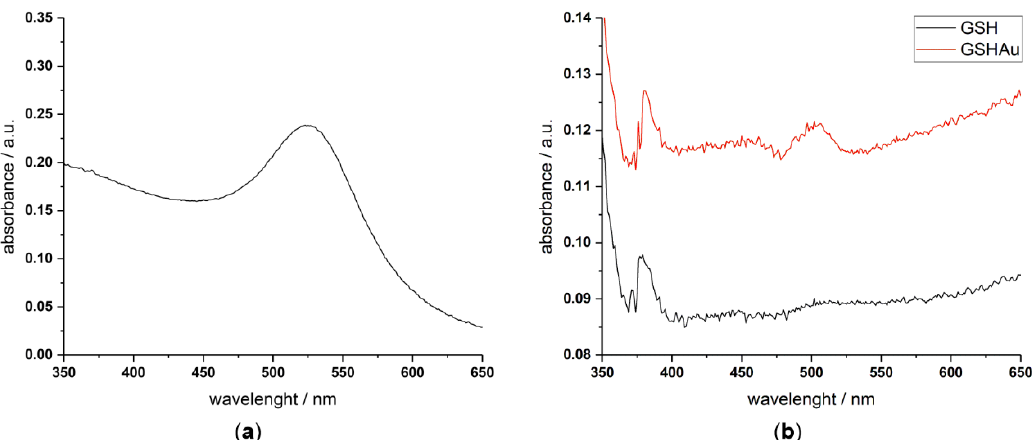
Figure 1. ( a ) Ultraviolet and visible spectrum of gold nanoparticles in the mixture composed of the commercial gold suspension and saline phosphate buffer solution. ( b ) Ultraviolet and visible diffuse reflectance spectra of glass containing -SH groups (GSH) and additionally covalently attached gold nanoparticles substrates (GSHAu).